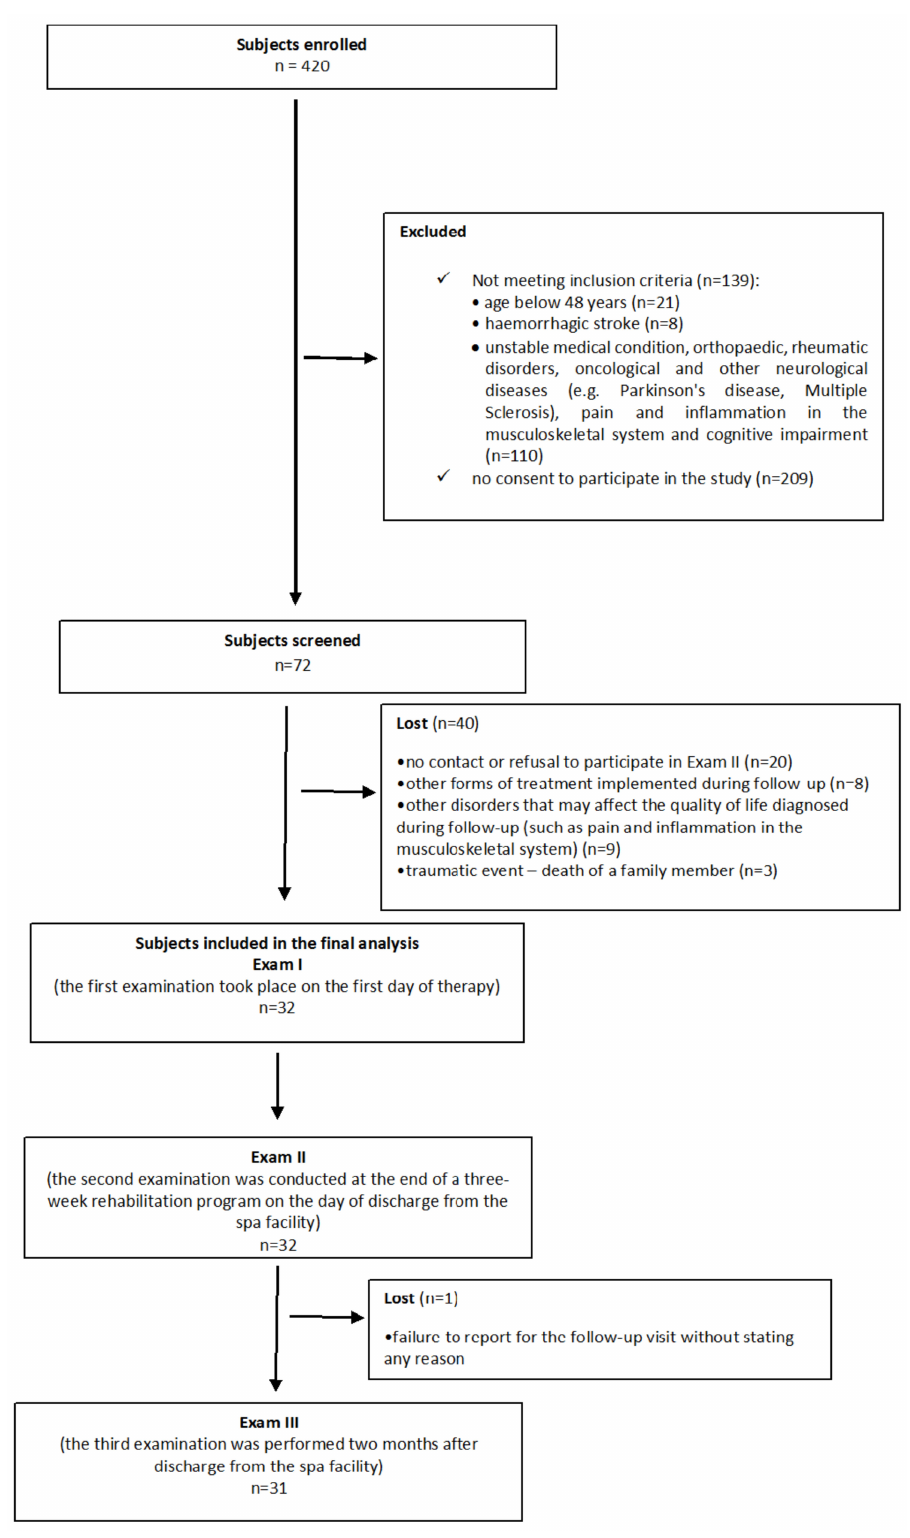
Figure 1. Flow diagram of the study